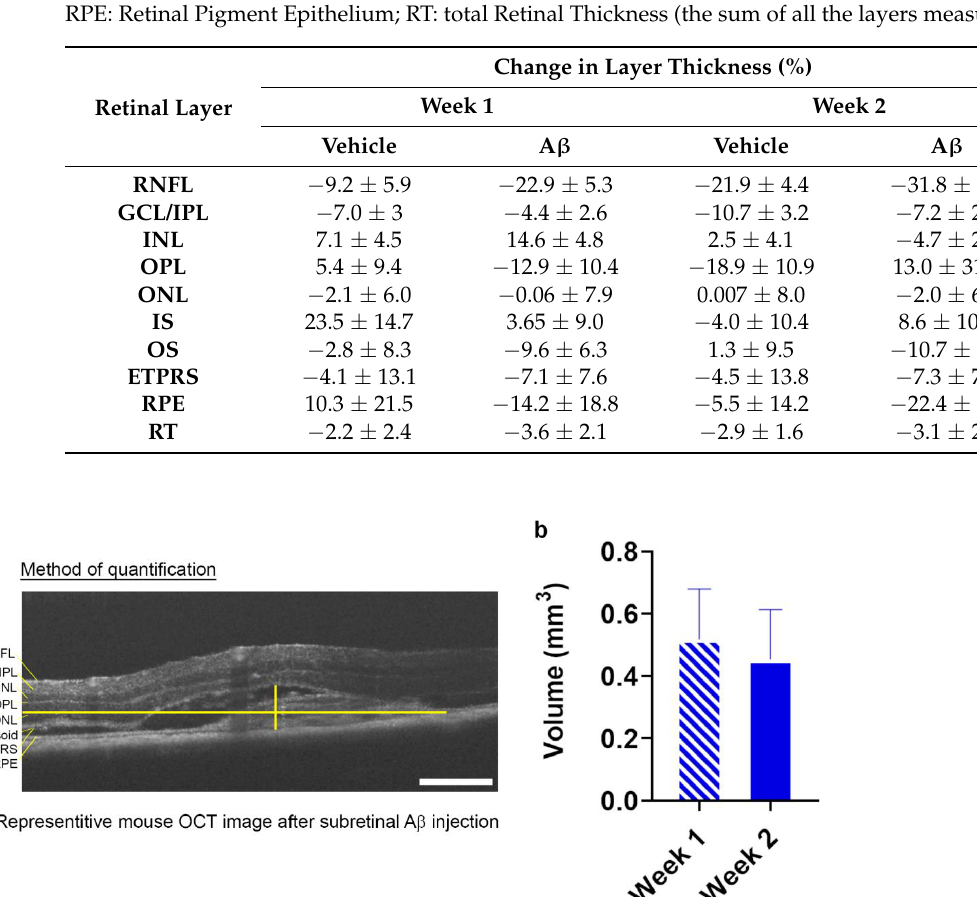
Table 4. Effects of subretinal A β on the global thickness/structure of individual retinal layers as well as total retinal thickness assessed by optical coherence tomography. Measurements were carried out in mice subretinally injected with either A β 1-42 ( n = 7) or vehicle ( n = 6) after 1 or 2 weeks. Data shown as an average percentage change from baseline +/- the standard error of the mean (SEM) to account for intra-animal variability. Statistical analysis using the Mann–Whitney U test revealed